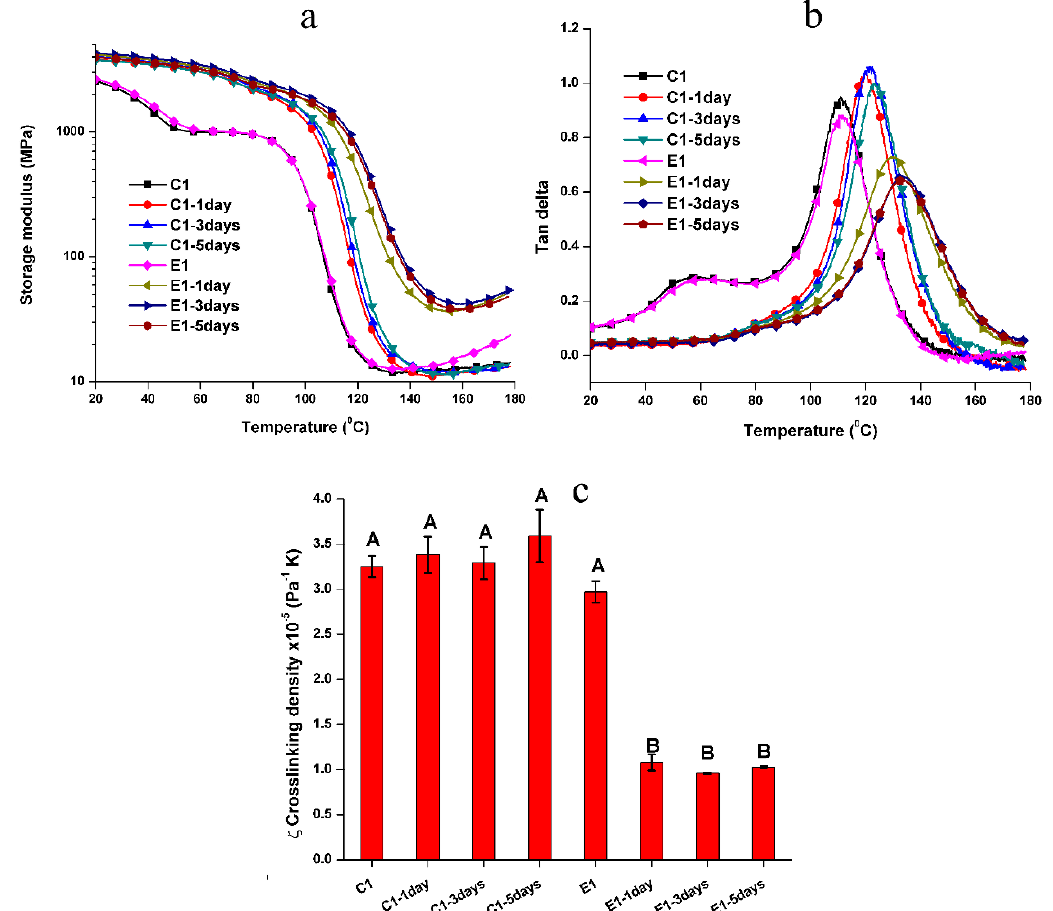
Figure 3 . Representative ( a ) storage modulus and ( b ) tan δ vs. temperature, and ( c ) the crosslinking density of the non-treated and treated C1 and E1 in dry conditions (the same letter indicates no statistically significant difference at the 0.05 level).